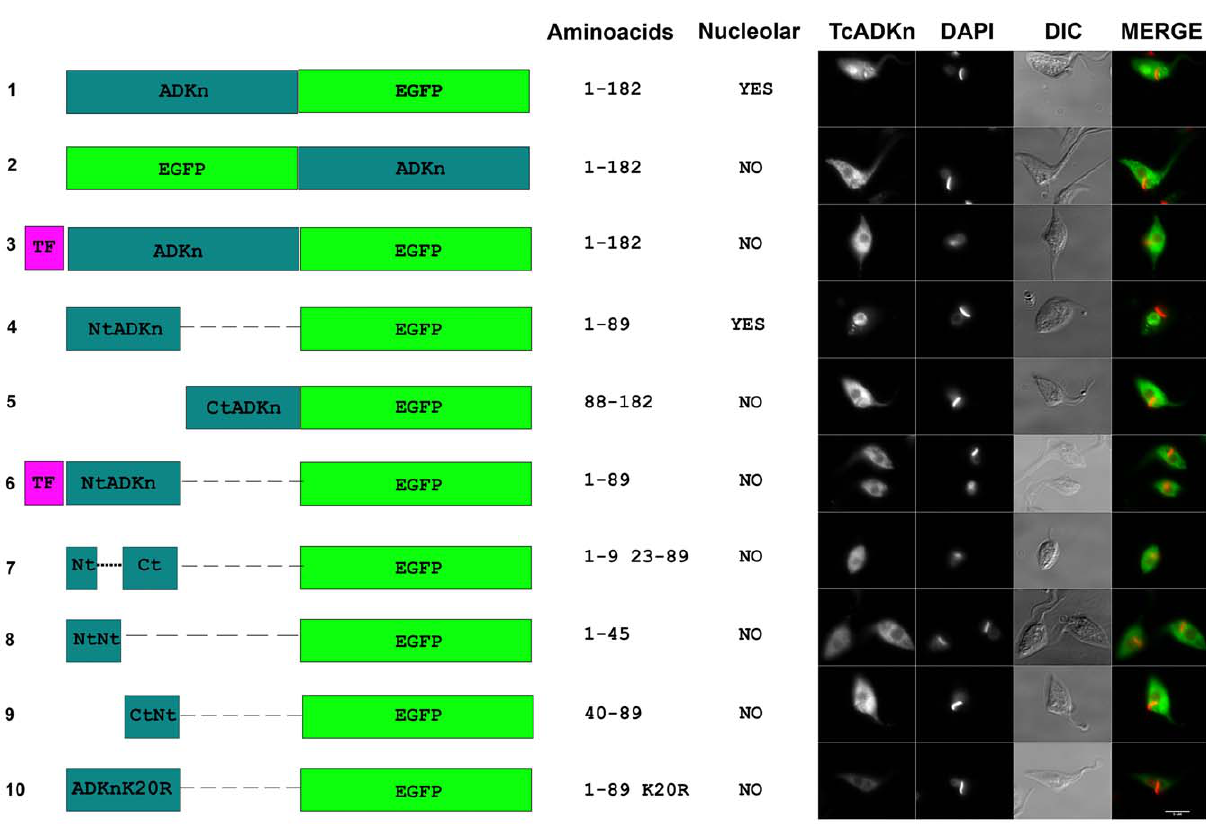
Figure 2. TcADKn nuclear localization signal. Deletion analysis and GFP fusions were built in order to determine the sequence responsible for TcADKn nuclear localization. The scheme on the left side shows the GFP fusions, indicating TcADKn amino acids range fused to GFP (Amino acids) and the resulting subcellular localization (Nuclear). T. cruzi epimastigotes were transfected with the constructions and fluorescence was followed by fluorescence microscopy NtADKn represents aminoterminal of the protein (1–89 amino acids), CtADKn represents the carboxiterminal of the protein (88–182 amino acids), NtNtADKn represents the aminoterminal of Nt (1–45 amino acids), Nt–Ct represents NtADKn were the p-loop has been deleted (1–9, 23–89 amino acids), CtNtADKn represents the carboxiterminal of NtADKn (40–89 amino acids). The non-classical NLS was mapped to the N- terminal (Nt) of the protein, being the catalytic lysine of the p-loop (K20) essential for its localization (ADKnK20R). Images corresponding to TcADKn, 4 9 ,6-diamidino-2-phenylindole (DAPI), differential interference contrast microscopy (DIC) and the merged images, are showed in the right panel.